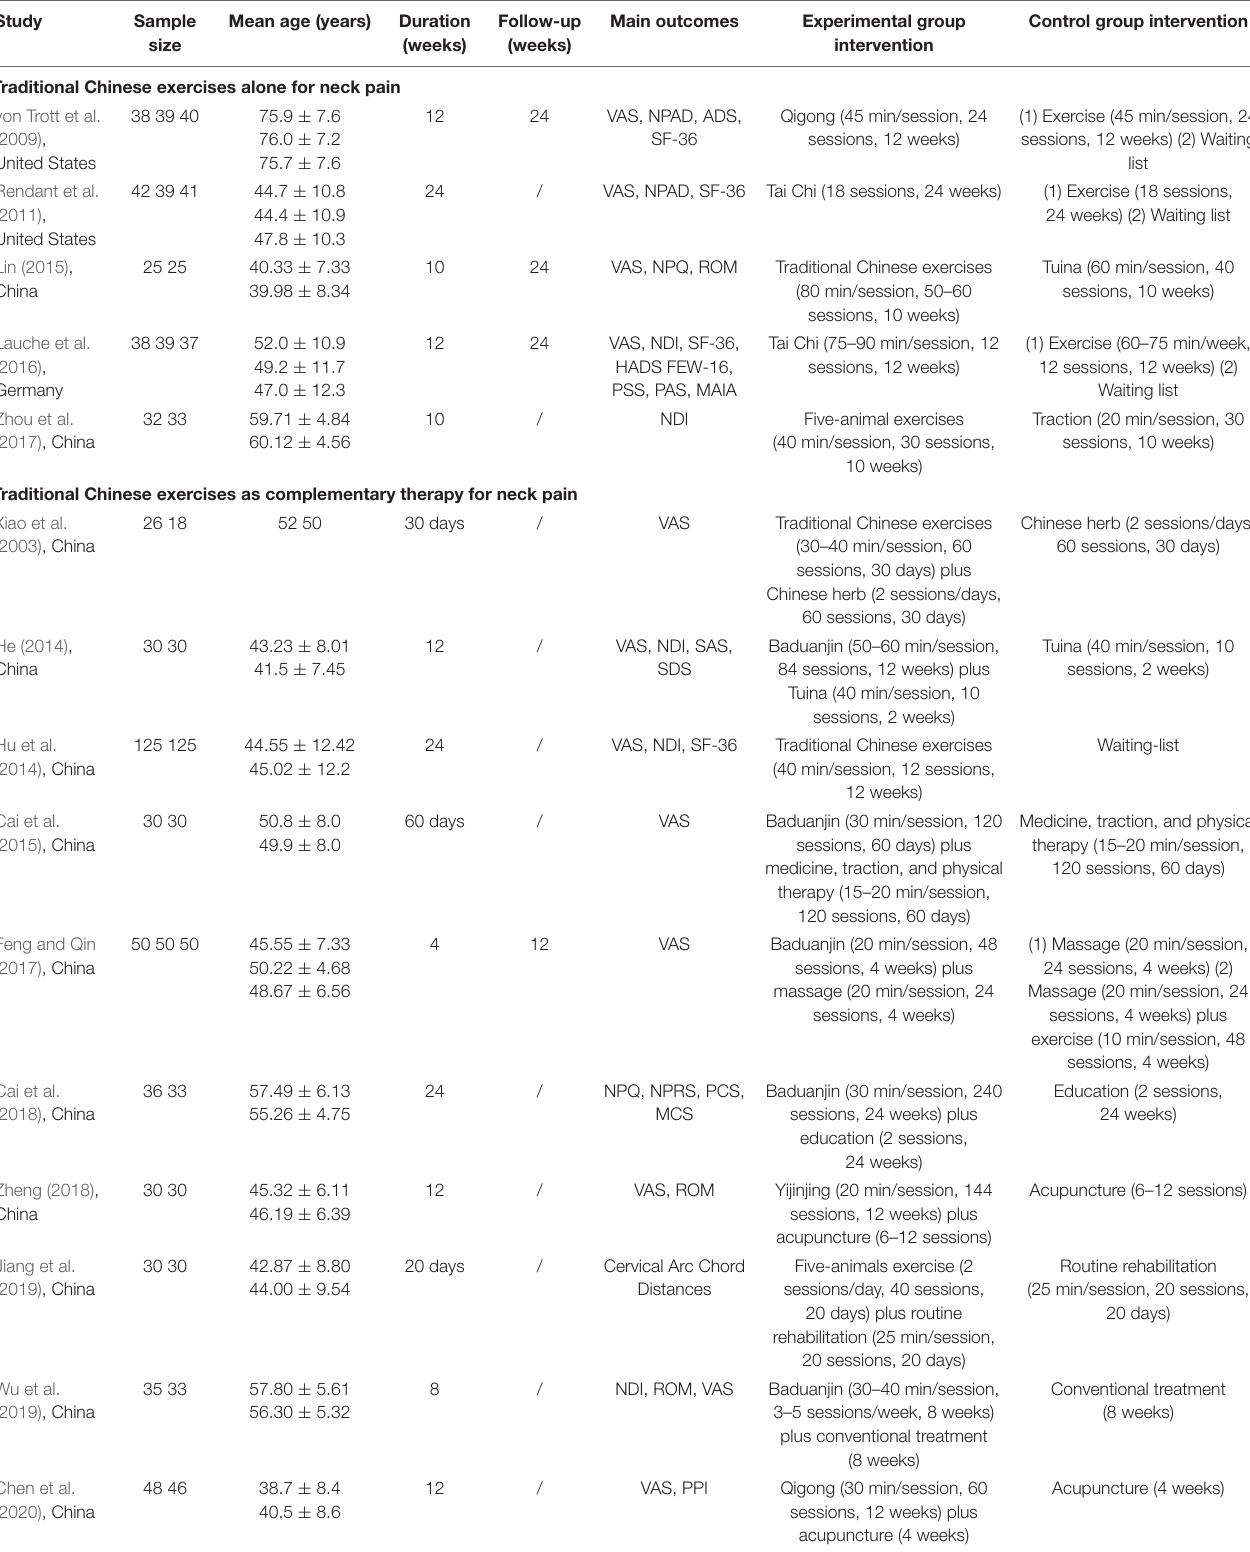
TABLE 1 | Randomized controlled trials evaluating the effects of traditional Chinese exercises for neck